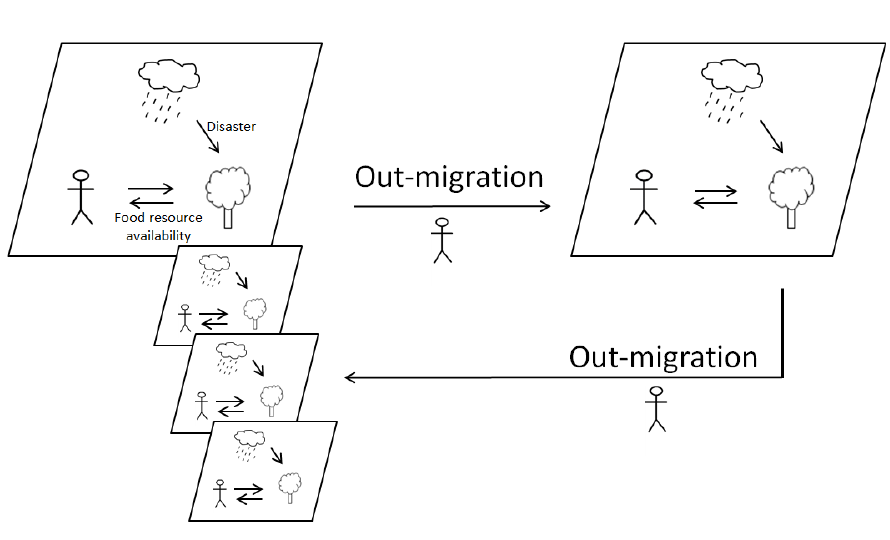
Fig. A1.9 Diagram drafted for the ABM described by Naqvi & Rehm (2014); agents do not make explicit return decisions, but migrate from region to region and can thereby visit a region again at some point in the future